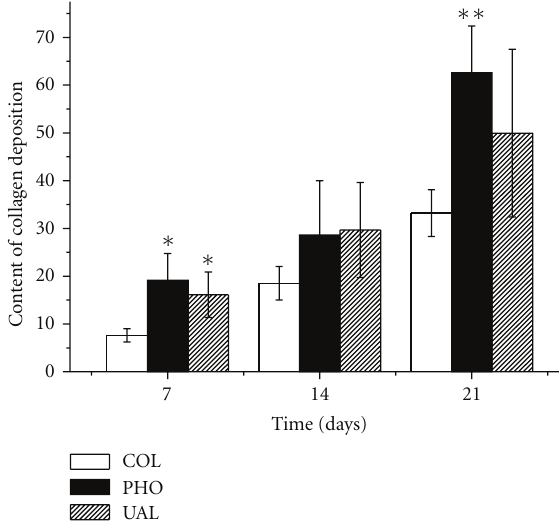
Figure 5: Quantitative analysis of the collagen content in the studied groups seven, 14 and 21 days after the burn proce- dures (COL—collagen-based dressing films; PHO—phospholipids- containing collagen-based dressing films; UAL—liposome-loaded usnic acid-containing dressing films). ∗ Di ff erent from COL P = . 02; ∗∗ Di ff erent from COL P = . 000.